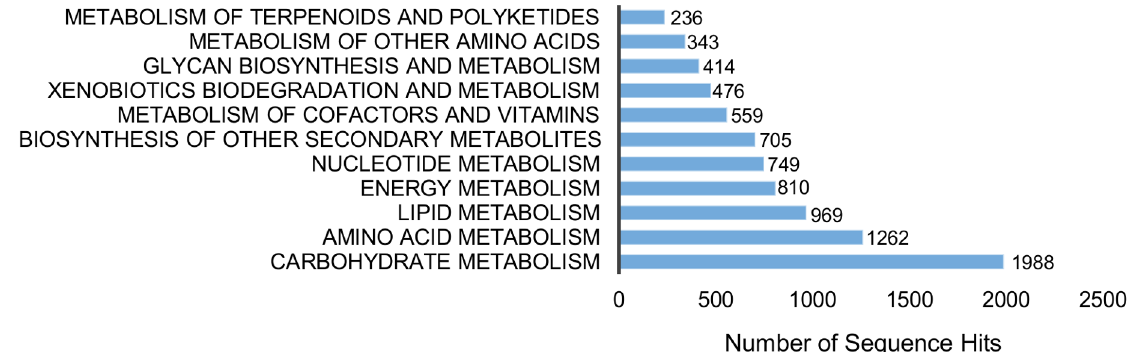
Figure 7. KEGG metabolism pathway distribution for the H.brasiliensis contigs.